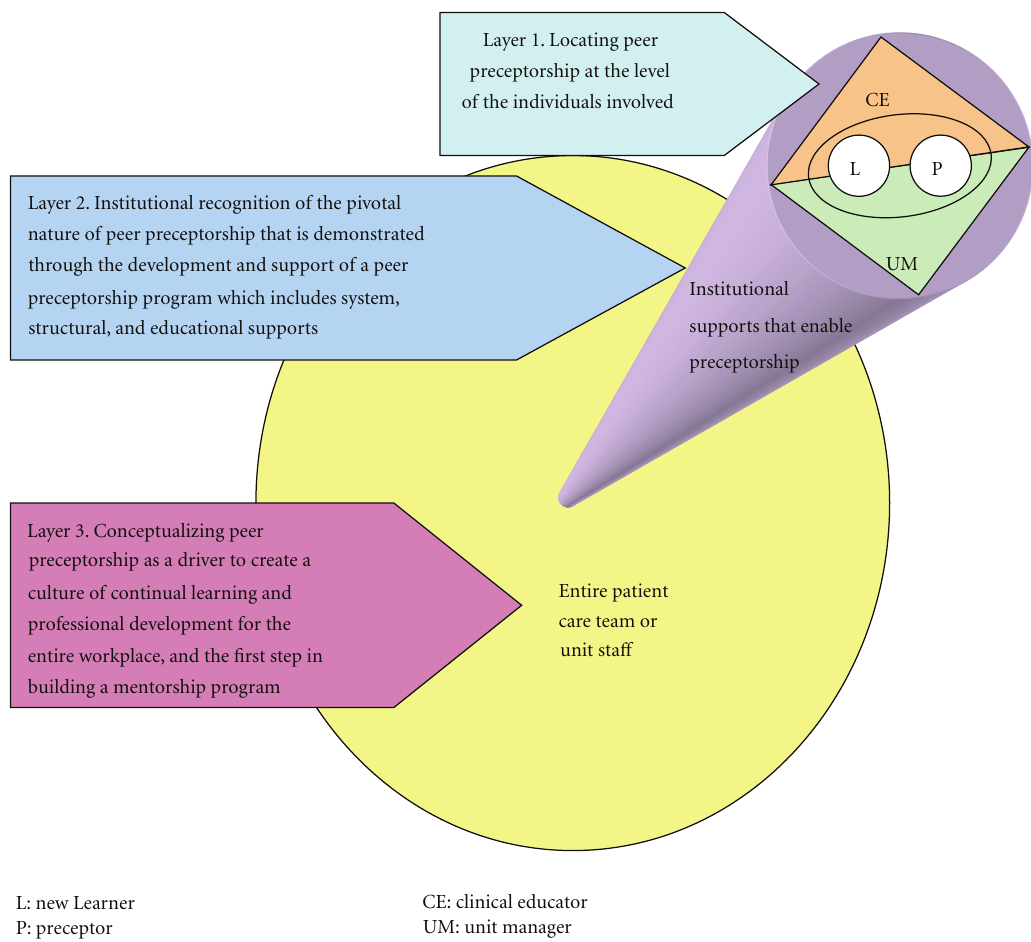
Figure 5: Conceptualizing the Relational layers of a Peer Preceptorship